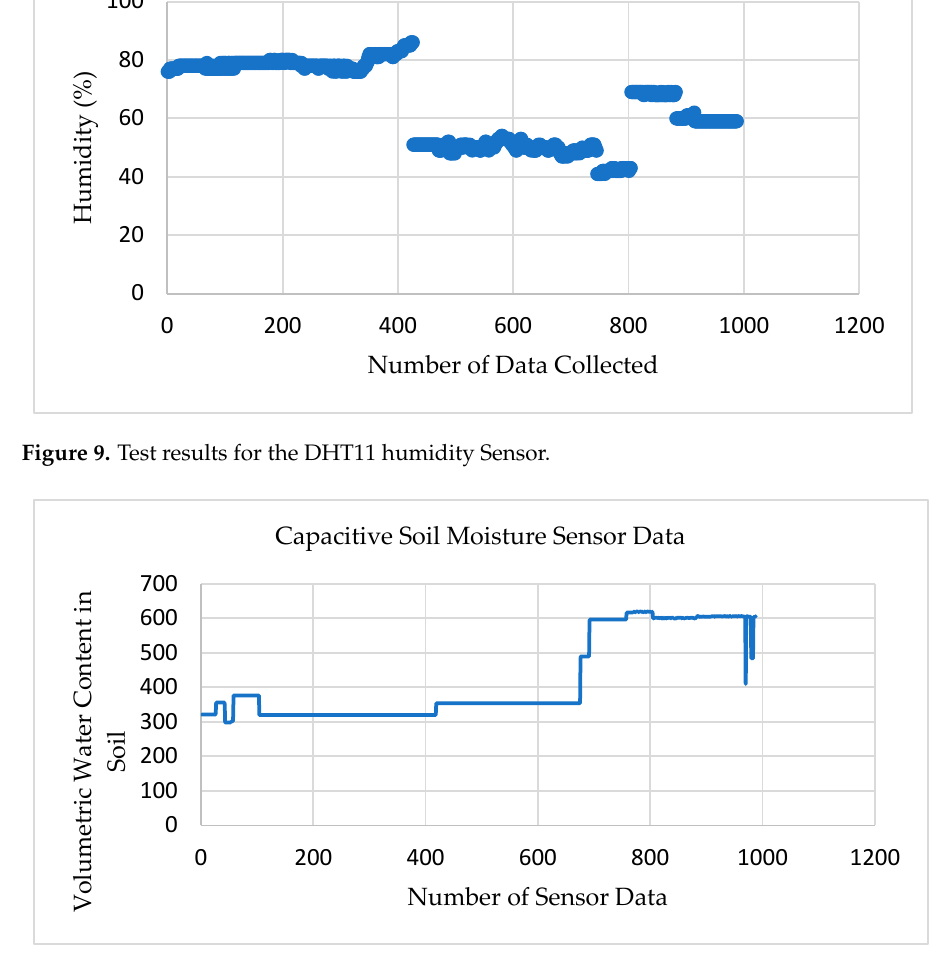
Figure 9. Test results for the DHT11 humidity Sensor.